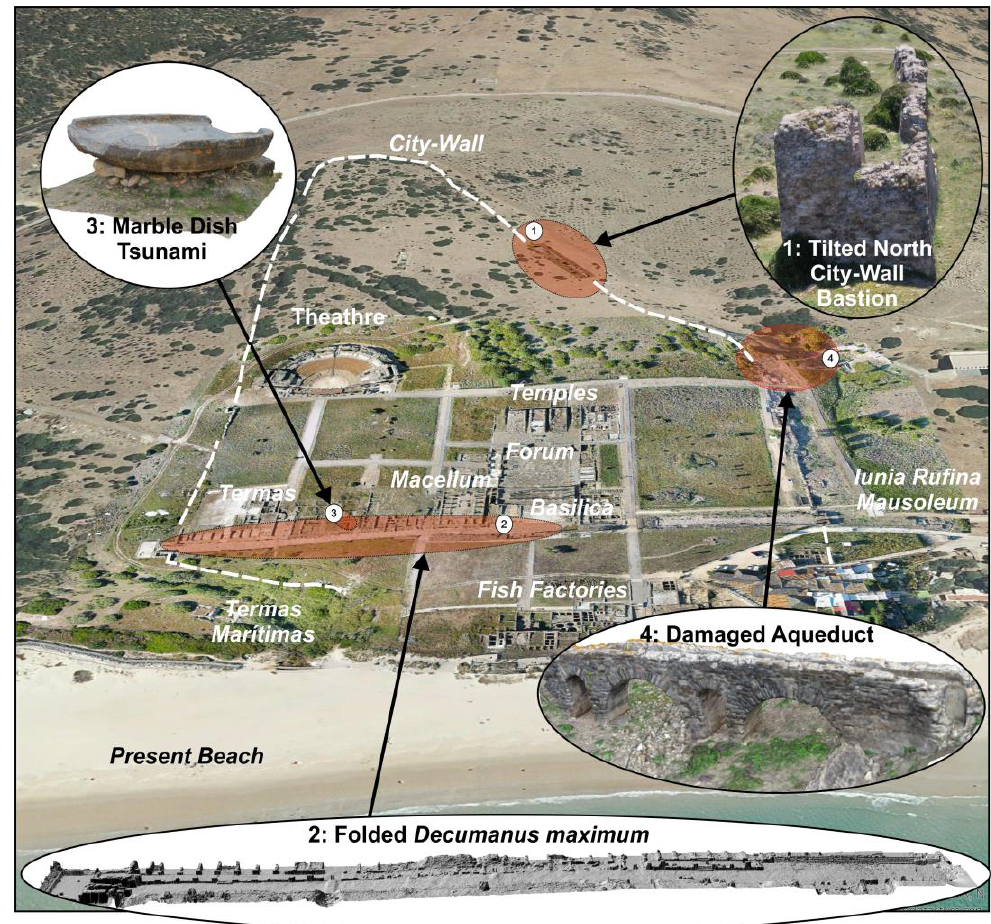
Figure 3. Aerial oblique view of the Baelo Claudia archaeological site highlighting the main buildings cited in the text with enlarged images of the 3D models analyzed in this paper.